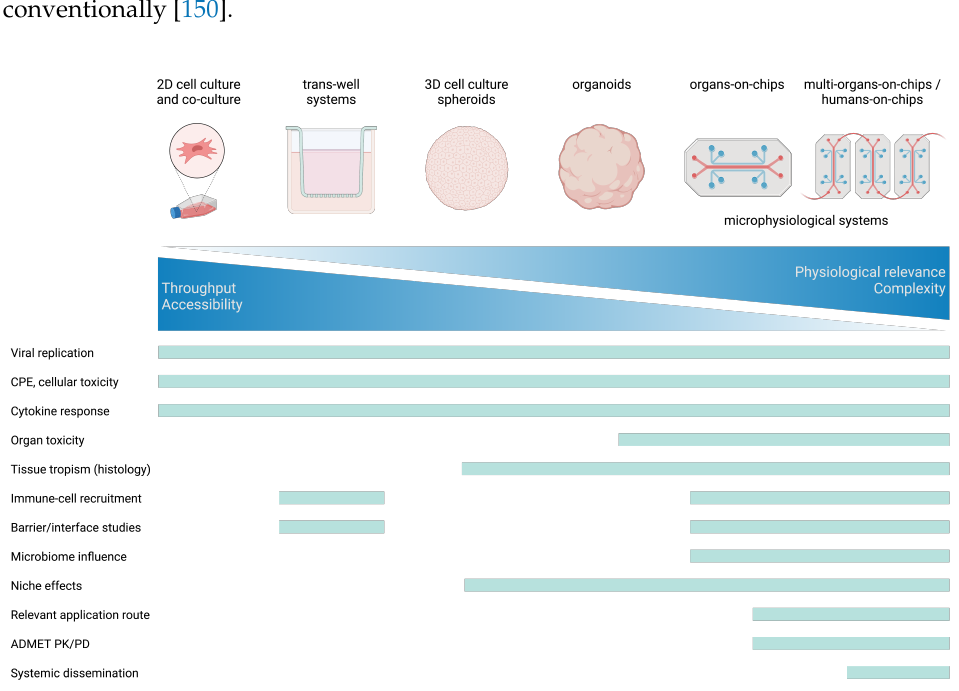
Figure 2. Capabilities and limitations of systems logy. Summary of experimental read-outs attainable in the respective systems. Created with